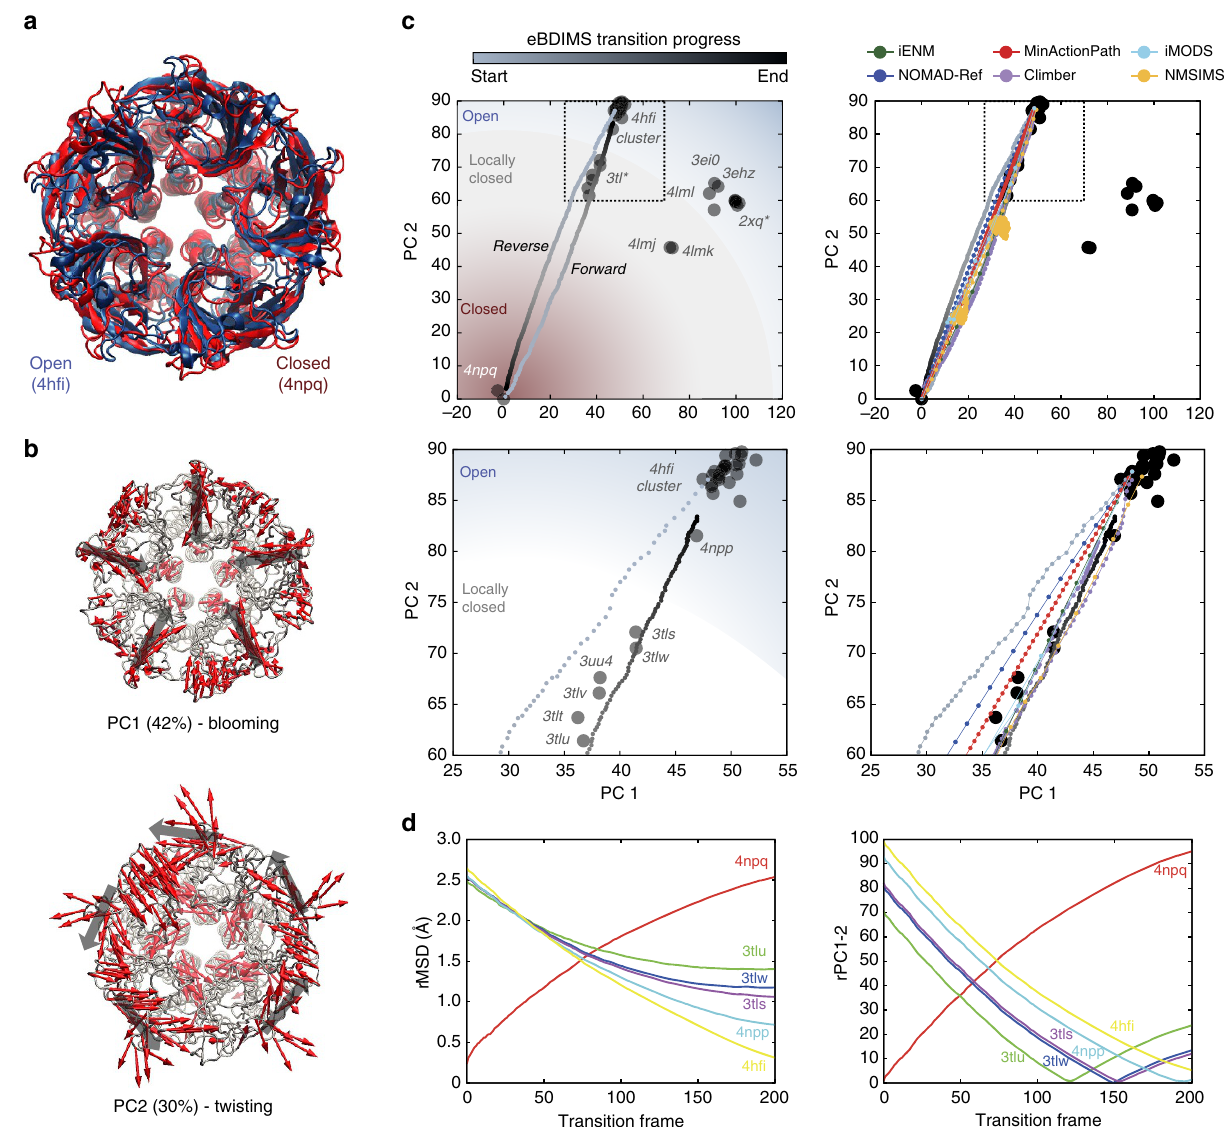
Figure 7 | Conformational transition of GLIC. ( a ) The two crystallographic structures representing the resting state (4npq) and the open conducting state (4hfi). ( b ) Dominant PCs of the GLIC X-ray ensemble (46 structures) versus 4npq. ( c ) Projection of the eBDIMS pathway onto the two major PCs of the ensemble (left); zoom highlighting the distribution of structures in the locally closed region (right). ( d ) Comparison between the forward pathways computed by eBDIMS, iENM, NOMAD-Ref, MinActionPath and Climber. Reverse pathways generated by eBDIMS, iMODS, NMSIM and Climber also